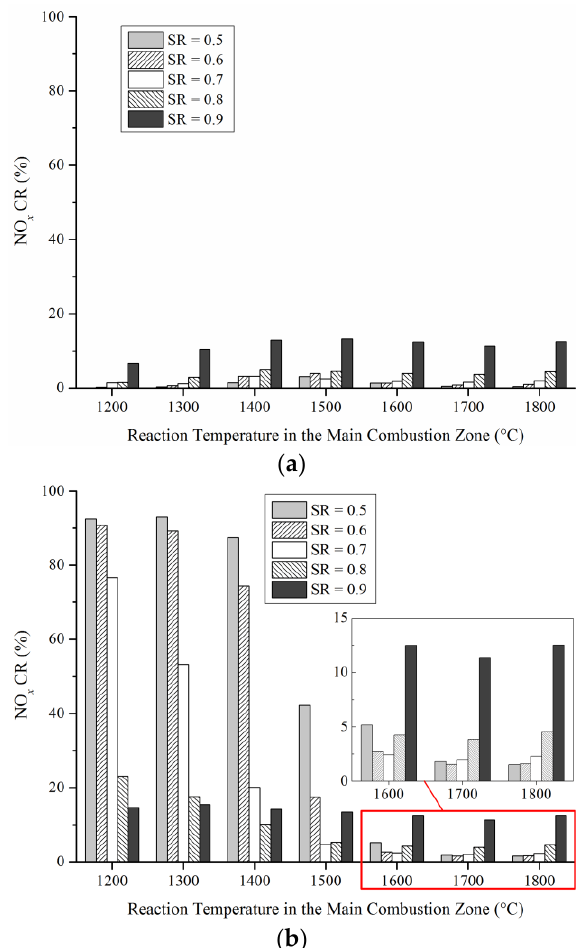
Figure 4. Conversion ratio of fuel-N to NO x in staged air combustion (reaction temperature in the burnout zone: 1100 °C): ( a ) main combustion zone exit; ( b ) burnout zone exit.